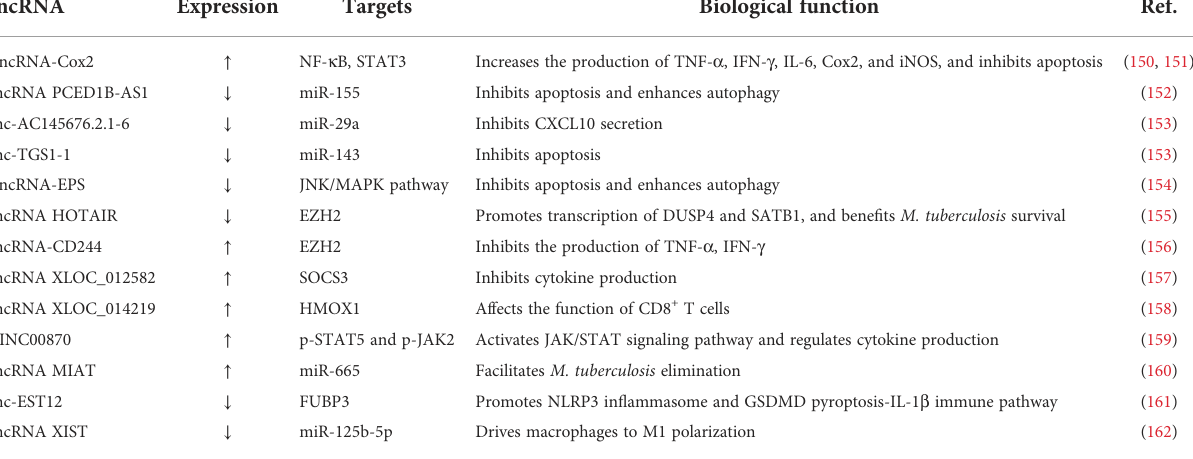
lncRNA, long noncoding RNA; Ref, reference; NF- k B, nuclear factor- k B; STAT, signal transducer and activator of transcription; TNF- a , tumor necrosis factor- a ; IFN- g , interferon- g ; IL, interleukin;Cox,cyclooxygenase;iNOS,induciblenitricoxidesynthase;JNK/MAPK,JunN-terminalkinase/mitogen-activatedproteinkinase;EZH2,enhancerofzestehomolog2;DUSP4, dual speci fi city MAP kinase phosphatase 4; SATB1, special AT-rich sequence binding protein 1; M. tuberculosis, Mycobacterium tuberculosis ; SOCS, suppressor of cytokine signaling; HMOX1,heme oxygenase1;JAK,Janus kinase; FUBP3,farupstream element-bindingprotein; NLRP3,nucleotide-binding oligomerizationdomain-likereceptor pyrindomain-containing protein 3; GSDMD, gasdermin D. ↑ , upregulated; ↓ ,